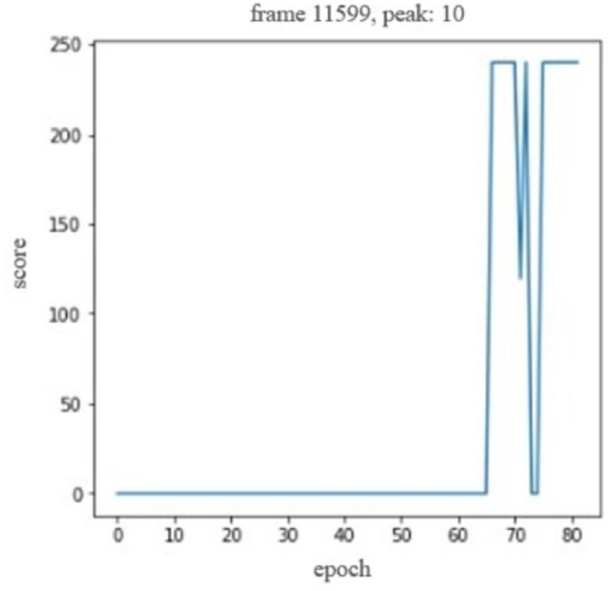
Figure 12. Soft Q-function (Q) imitation learning training graph for a placement task.